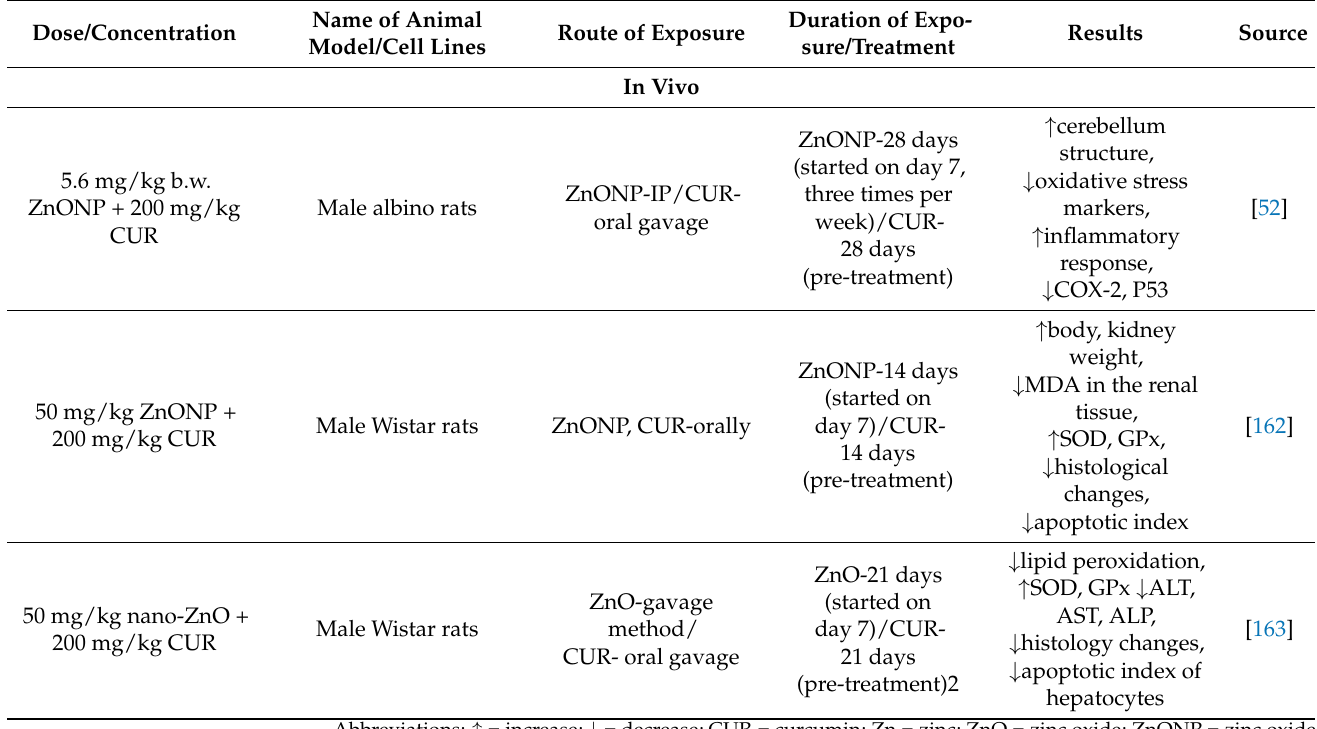
Table 8. Effects of curcumin on zinc toxicity based on doses, experimental methods, and